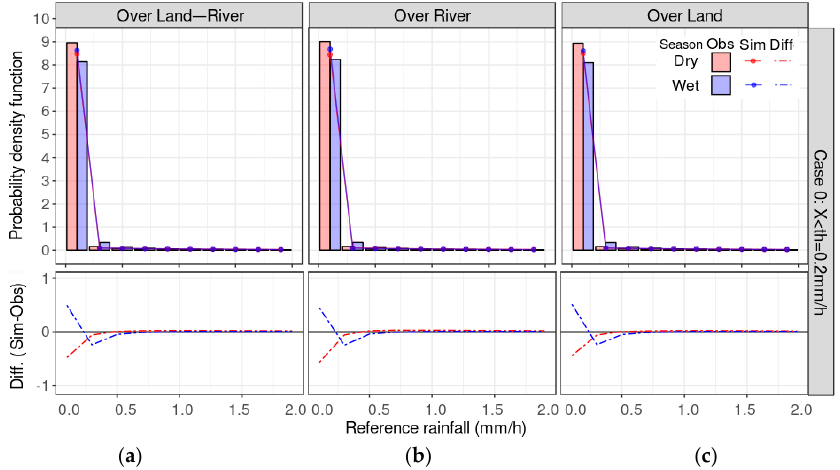
Figure 3. Histogram of the correct no-precipitation detection error (Case 0) for the 0.2 mm h − 1 threshold over land–river ( a ), river only ( b ), and land only ( c ) during the dry (red) and wet (blue) seasons. Bars indicate the observed probability density function (PDF), dotted lines represent the simulated PDF, and dashed lines are the PDF differences (simulated–observed).